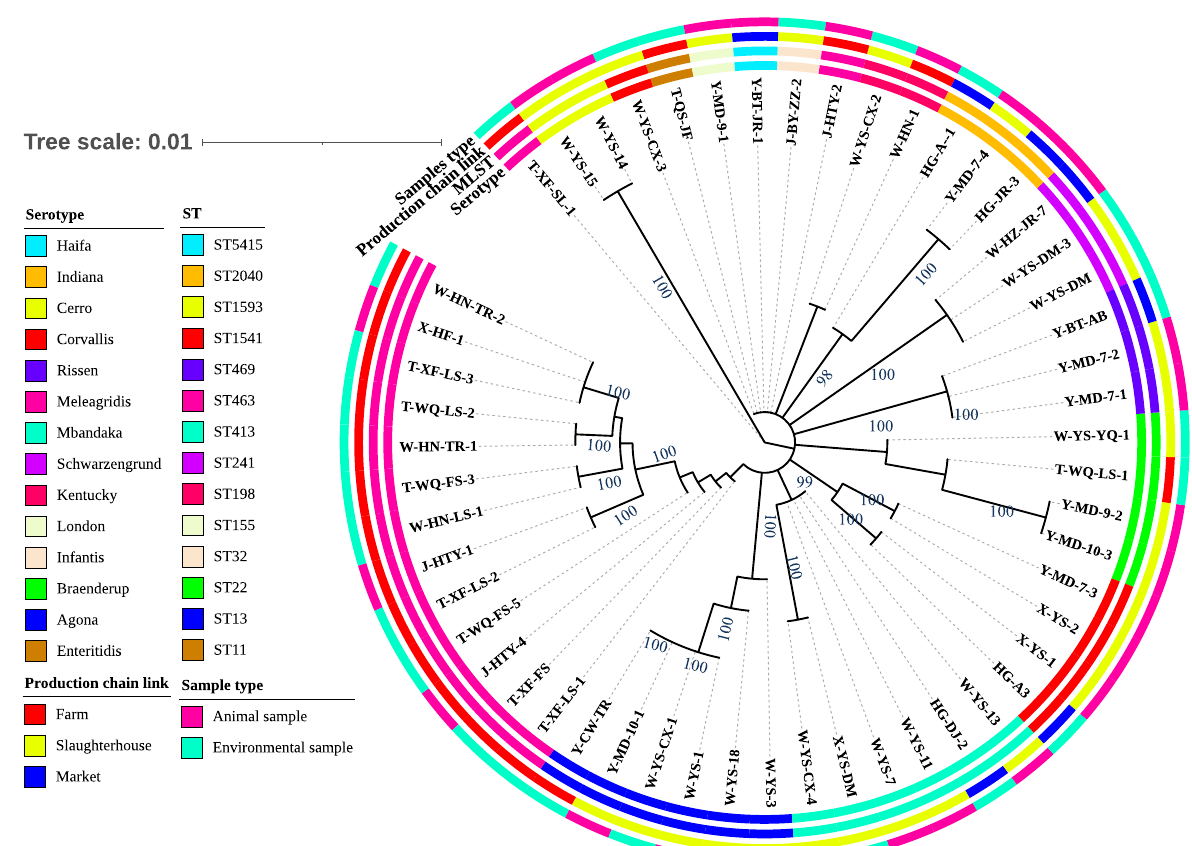
Fig. 5 Cluster of ST types based on MLST analysis and serotypes of 53 Salmonella